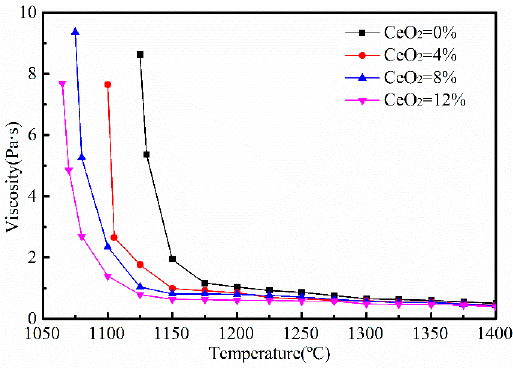
Figure 4. Viscosity results of experimental mold fluxes with decreasing temperature.